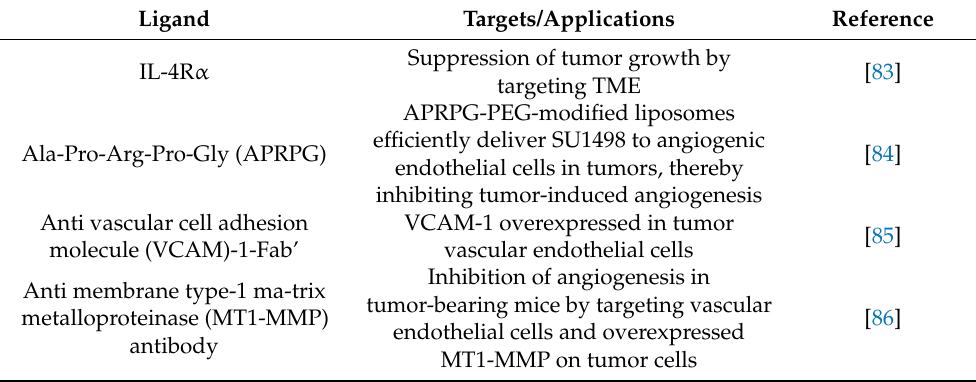
Table 2. Examples of ligands for liposomes targeting